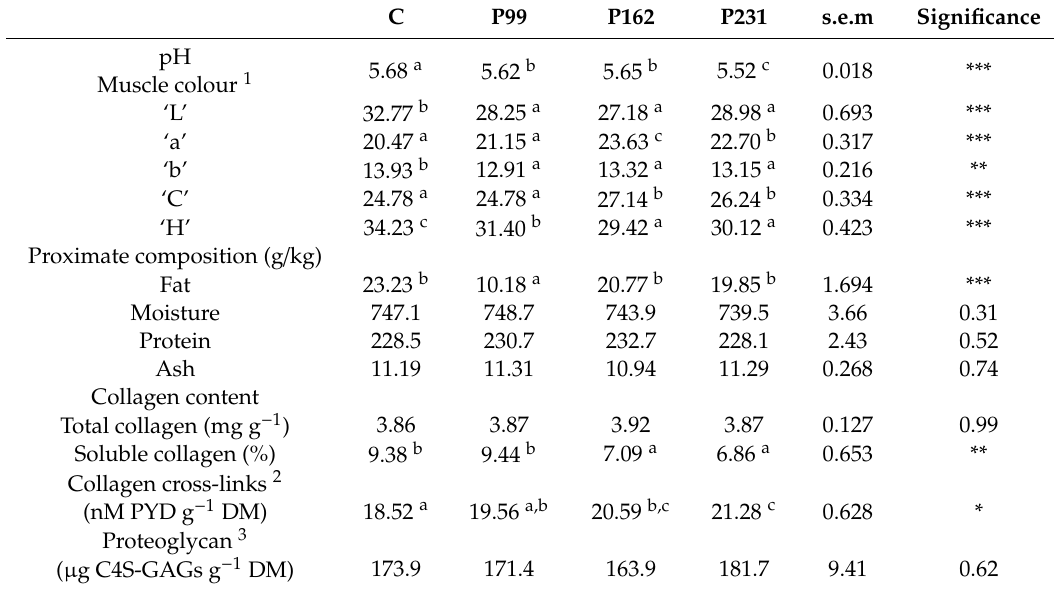
Table 3. pH at 48h post-mortem, colour, proximate composition and connective tissue characteristics of longissimus thoracis muscle from bulls raised on either a concentrate-based system (C) or pasture-based systems incorporating 99 days (P99), 162 days (P162) or 231 days (P231) grazing prior to indoor finishing on a concentrate-based